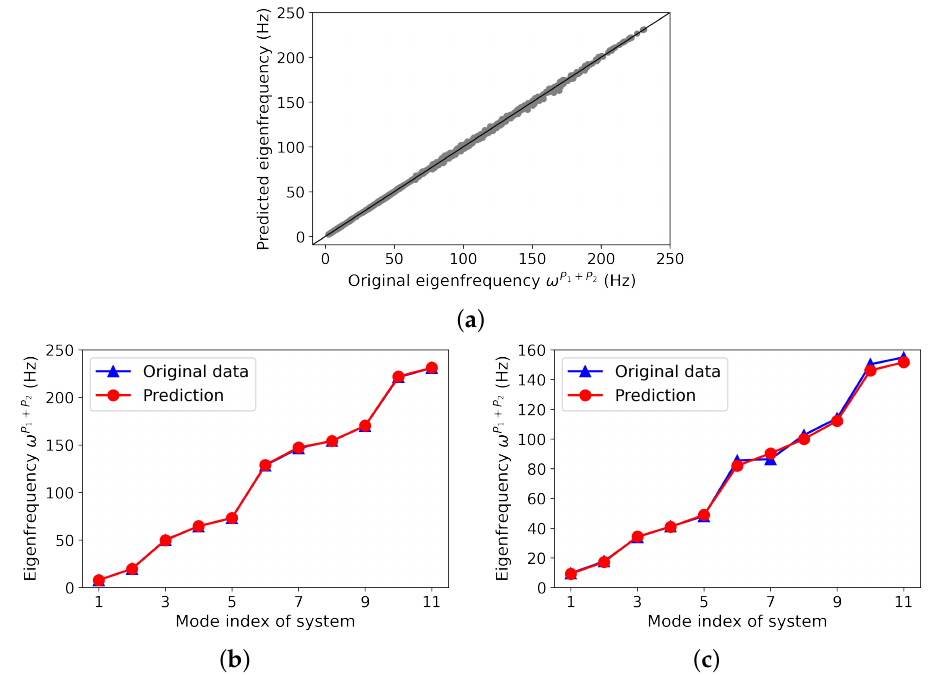
Figure 8. Comparison of predicted and original values of system eigenfrequencies for the training set.